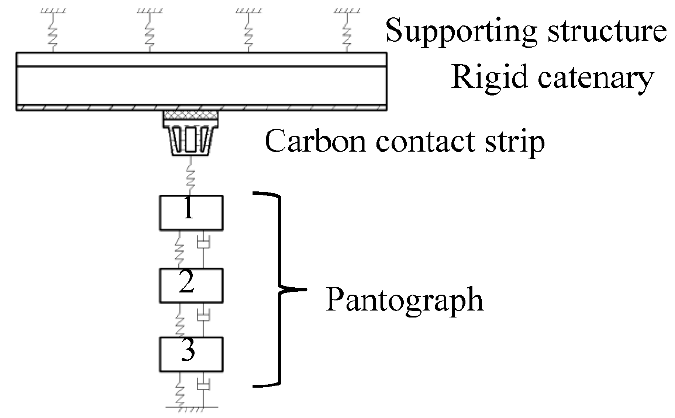
Table 3. Definition of parameters of the pantograph–catenary contact model.